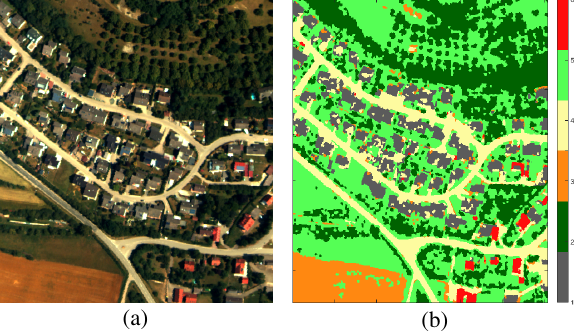
Figure 8. RGB and labeled image visualization. (a) shows the Greding scene and (b) the automatically generated image.